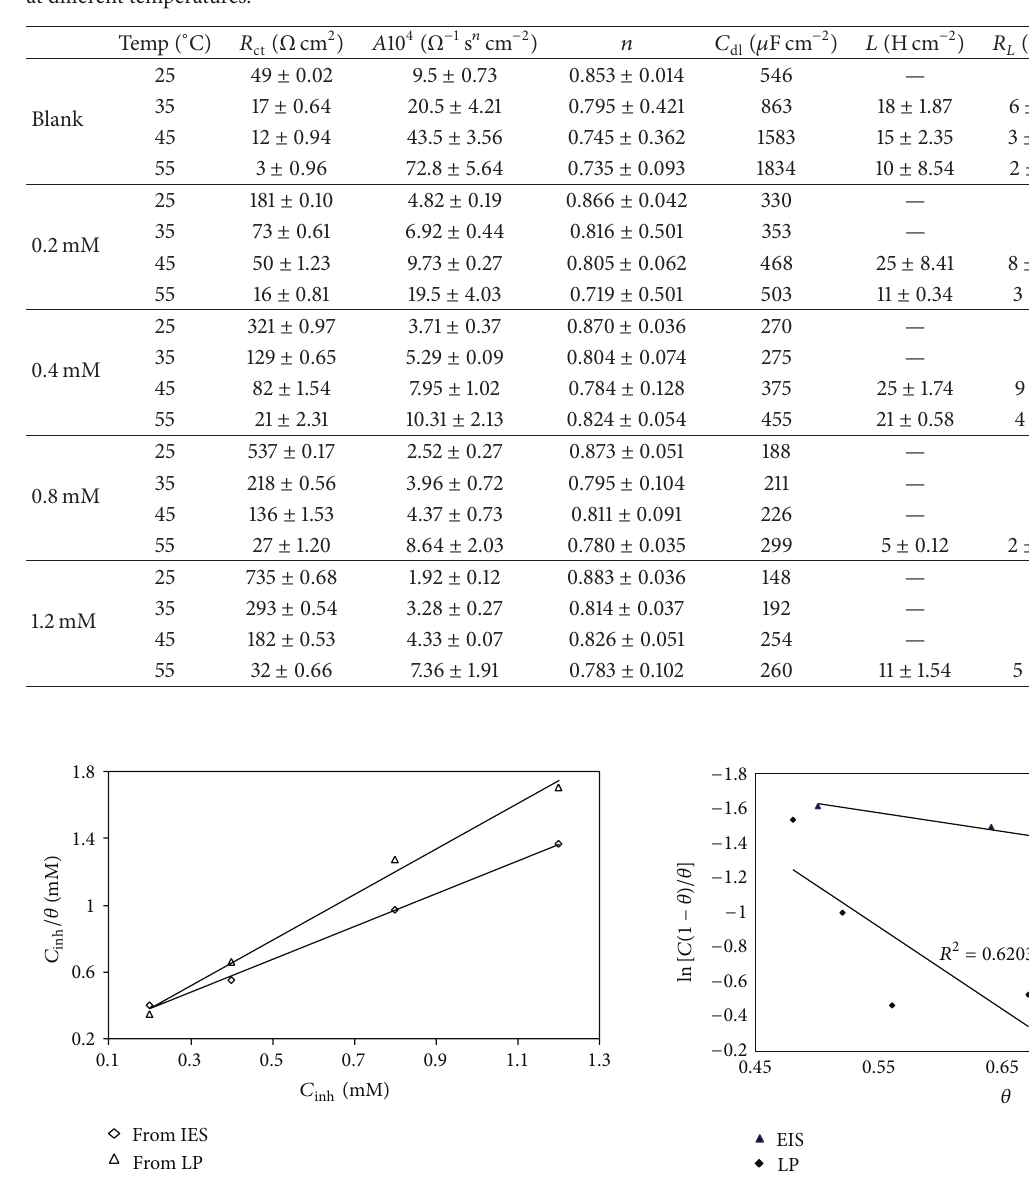
Figure 15: Langmuir adsorption plots for C38 steel in 1M HCl containing different concentrations of norharmane at 55 ∘ C.